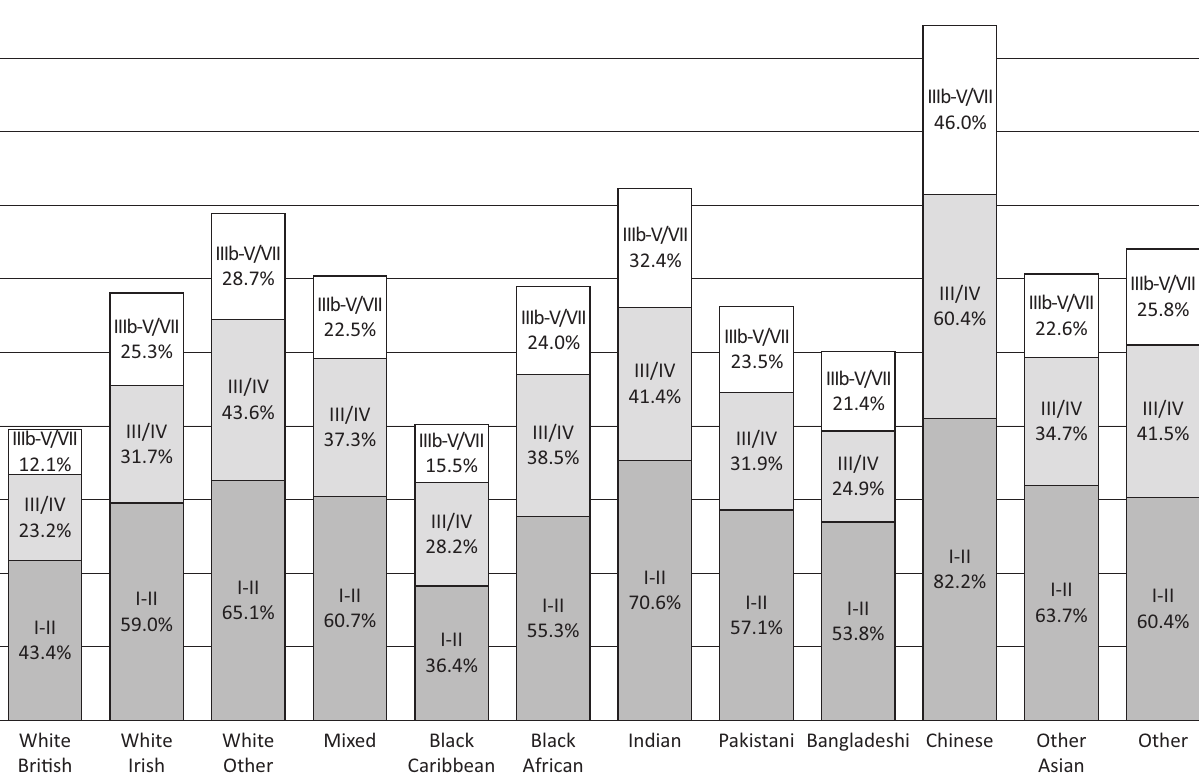
Figure 2. Degree-level attainment by ethnicity and parental social class. Source: Understanding